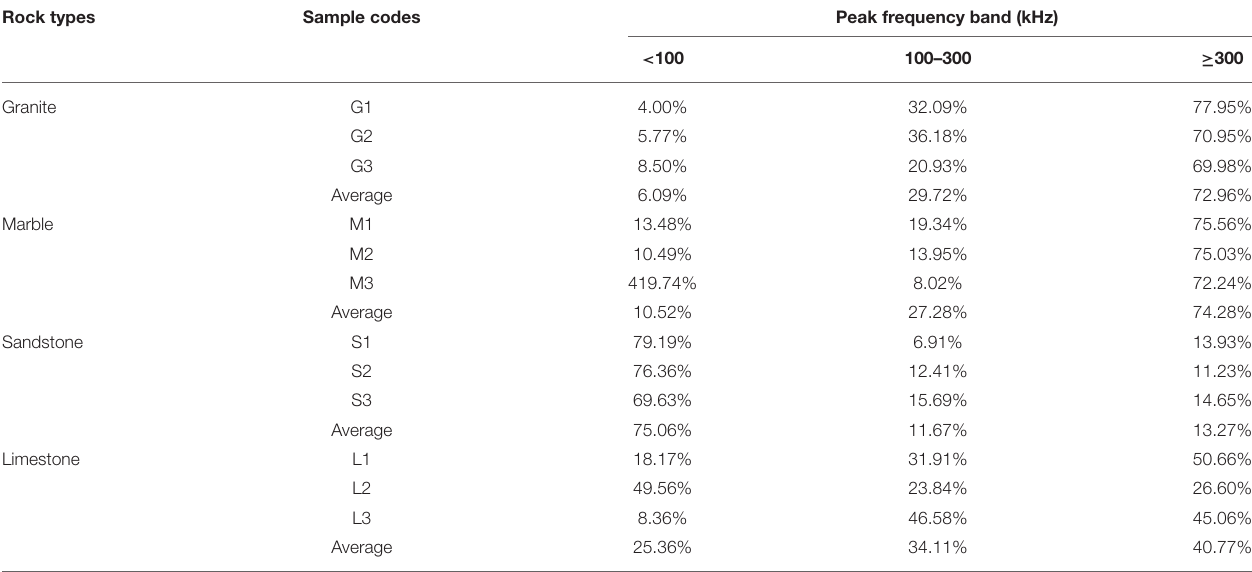
TABLE 1 | Distribution percentage of AE peak frequency for four rock types under Brazilian split test. Rock